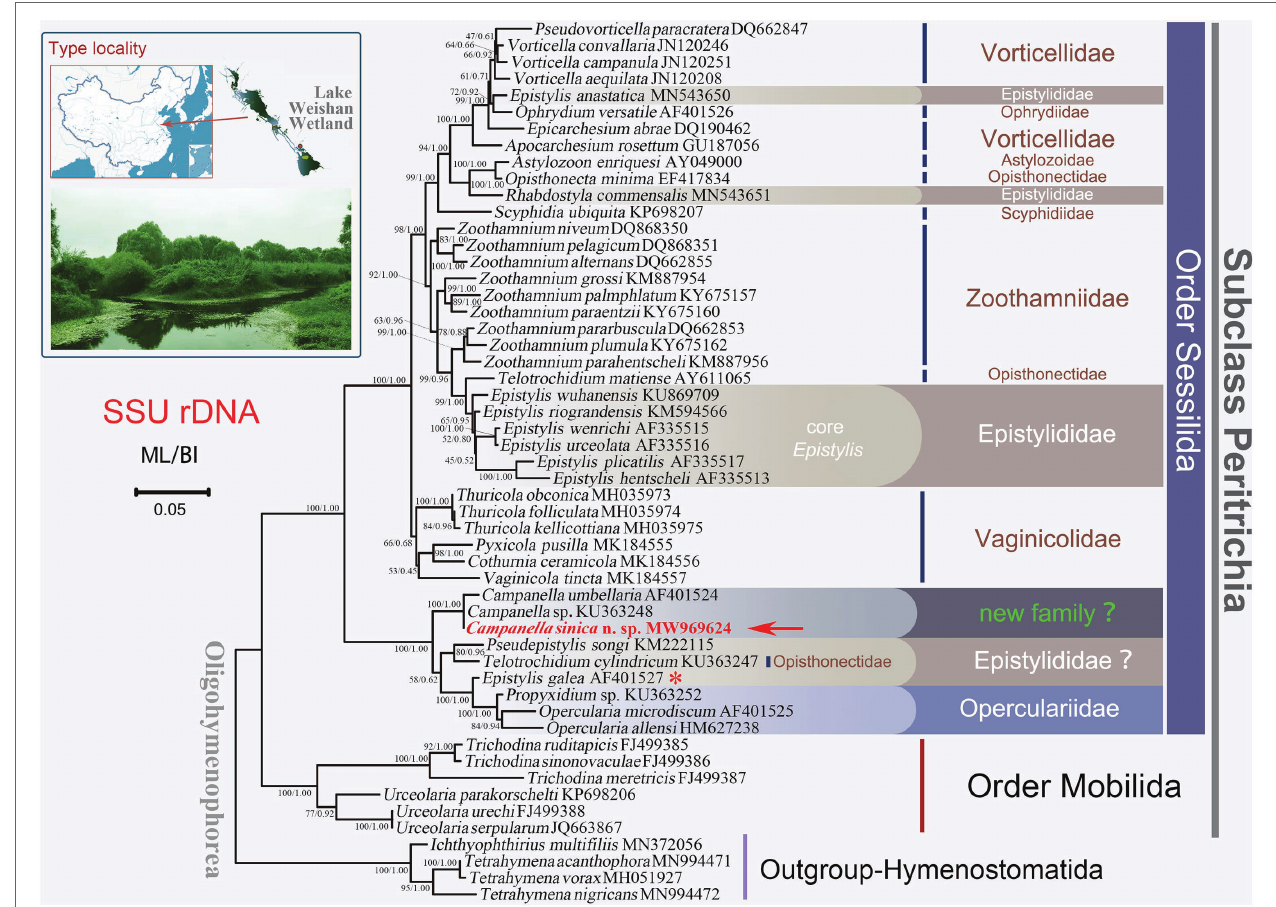
FIGURE 1 | Maximum likelihood (ML) tree inferred from small subunit ribosomal DNA (SSU rDNA) sequence data. Sequence of Campanella sinica n. sp. is in red and indicated by an arrow. Numbers given at nodes of branches are the ultrafast bootstrap percent (UF) values for ML analysis and posterior probability (PP) values for BI analysis. The scale bar corresponds to five substitutions per 100 nucleotide positions. The asterisk represents the validity of this sequence needs to be